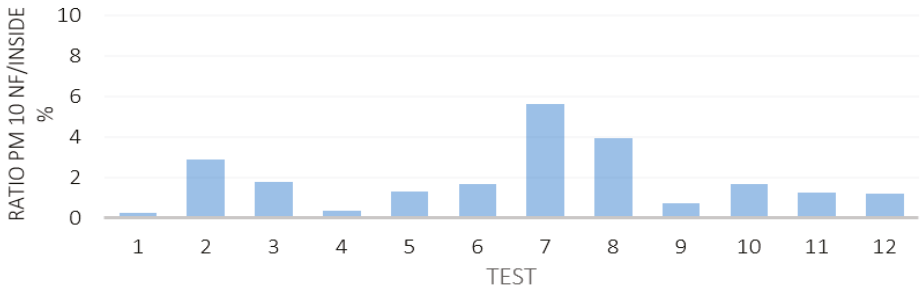
Figure 8. Percentage ratio between particle mass concentration measured at NF and inside the spray chamber using two DustTrak instruments.